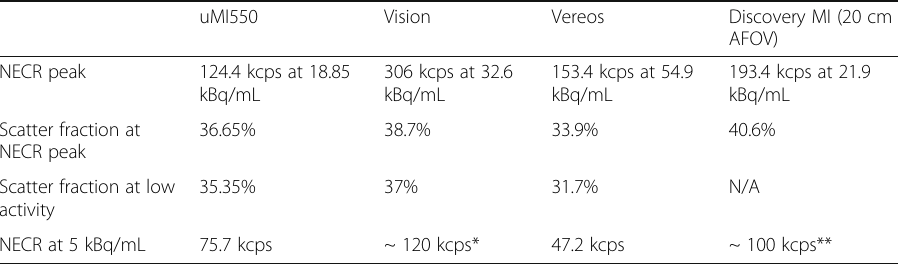
Table 5 A comparison of count-rate performance among different scanner models